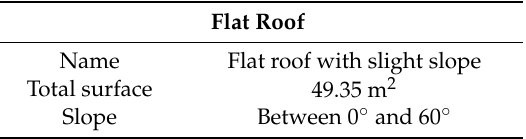
Table 10. Extracted data of flat roof out of the EPC document.